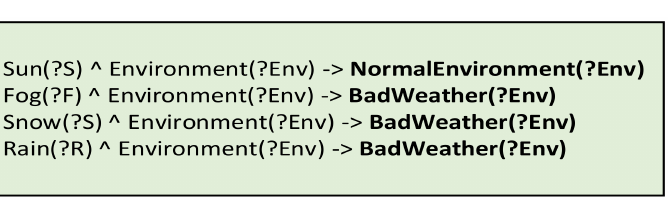
Figure 14. Classification of the environment based on the weather.